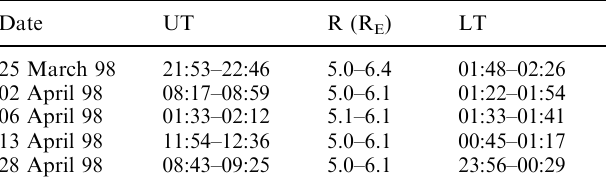
Table 1. Periods of inner-magnetosphere EDI high-rate data from March 25 through the end of the